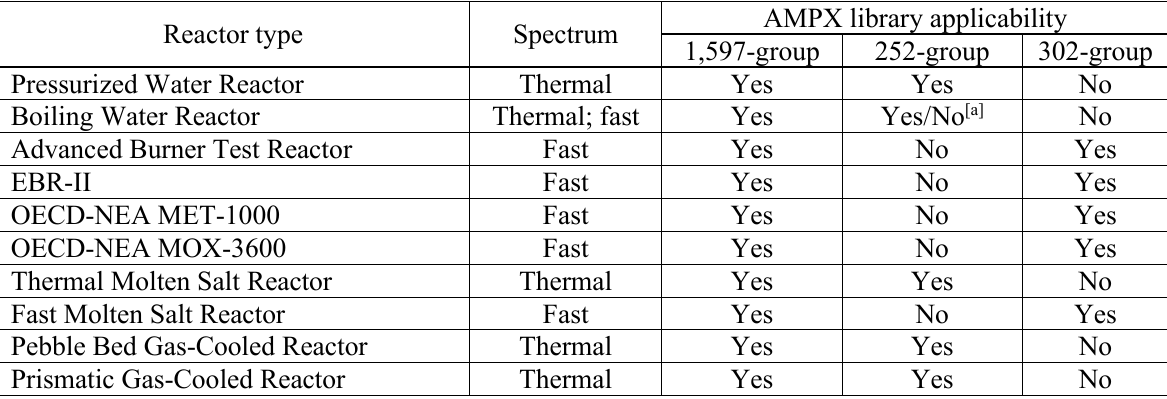
Table I. Applicability of the AMPX MG libraries to various reactor types